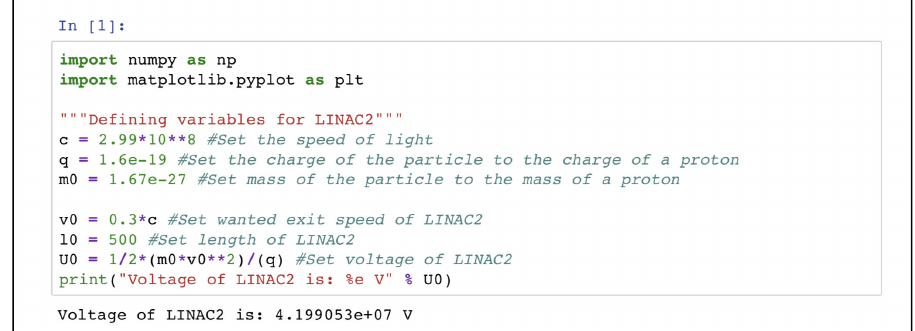
FIG. 5. Example of thoroughly documented code, including textual explanations, general in-line comments (red) and specific comments